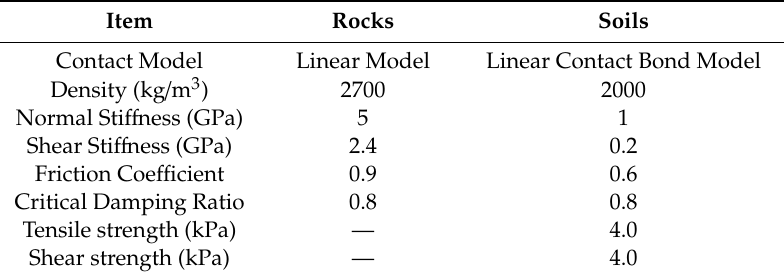
Table 5. Mesoscopic parameters and contact